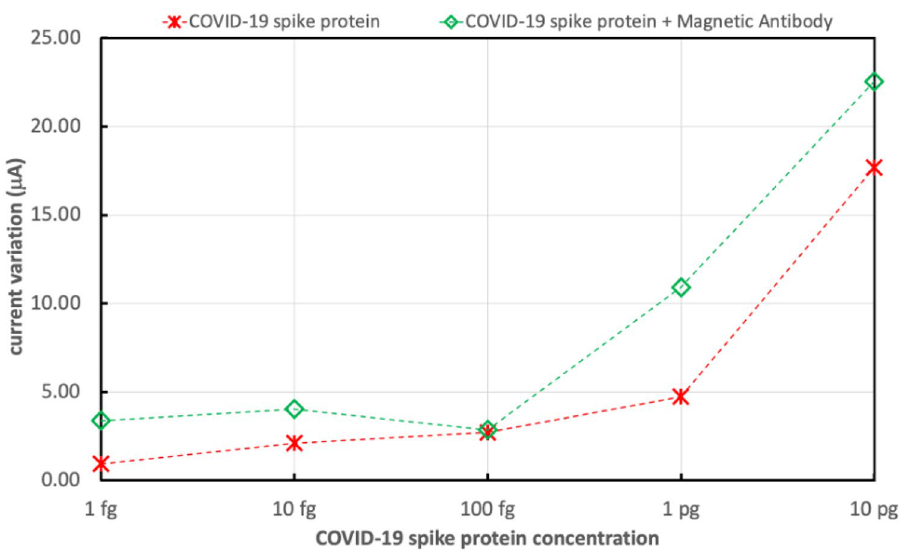
Figure 13. Variations in the electrical drain current of FET biosensor without nanoparticles due to different concentrations of COVID-19 spike antigen without and with the addition of magnetic